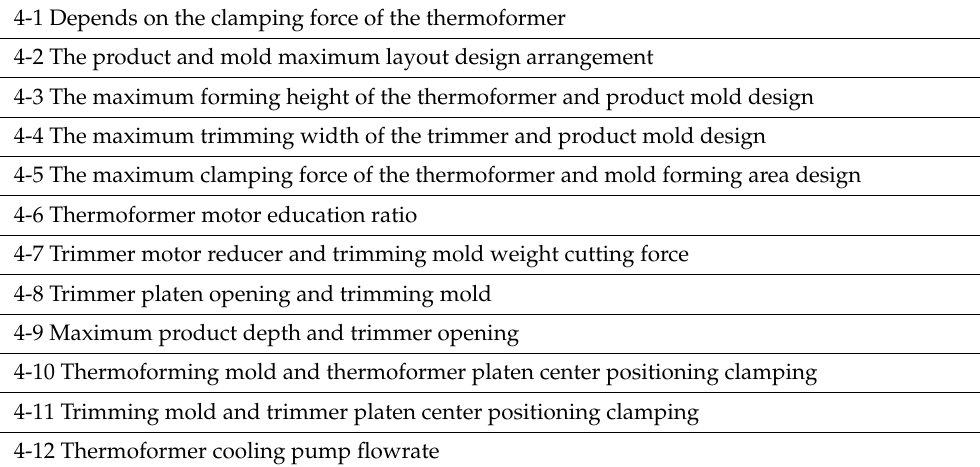
Table 5. Key factors of mold and thermoforming line equipment design (12 subitems).